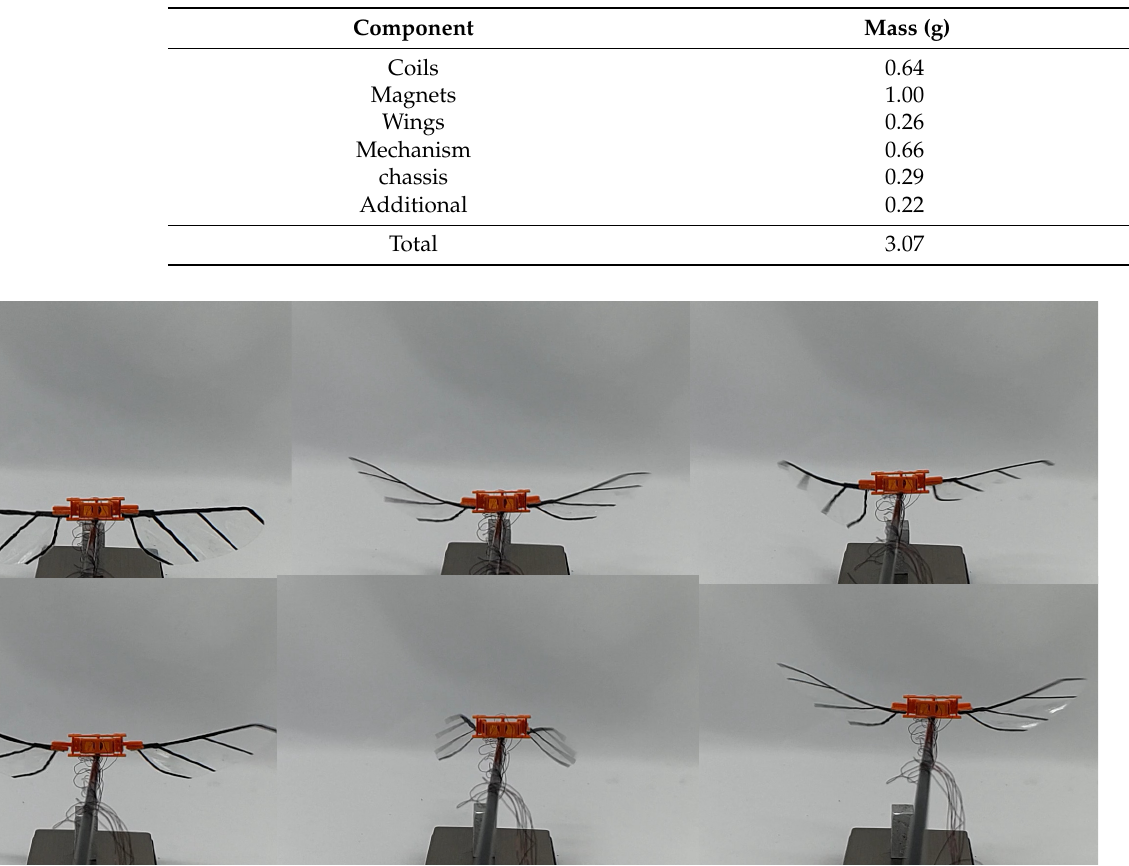
Figure 14. A time lapse of the system under test achieving tethered liftoff. The interval between images is approximately 80